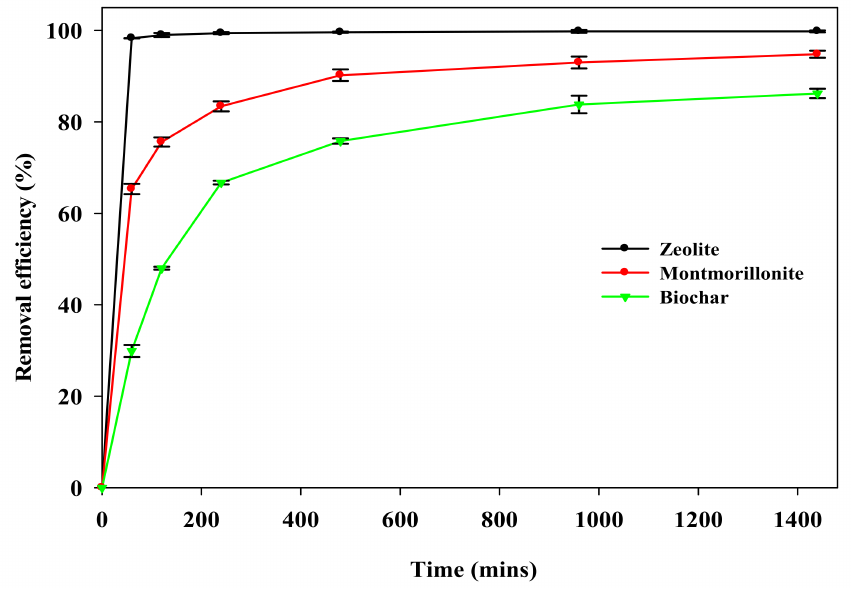
Figure 2. Kinetics of 226 Ra removal onto three investigated sorbents (at initial activity concentration 5 Bq L − 1 , sorbent dose 20 g L − 1 , and pH =